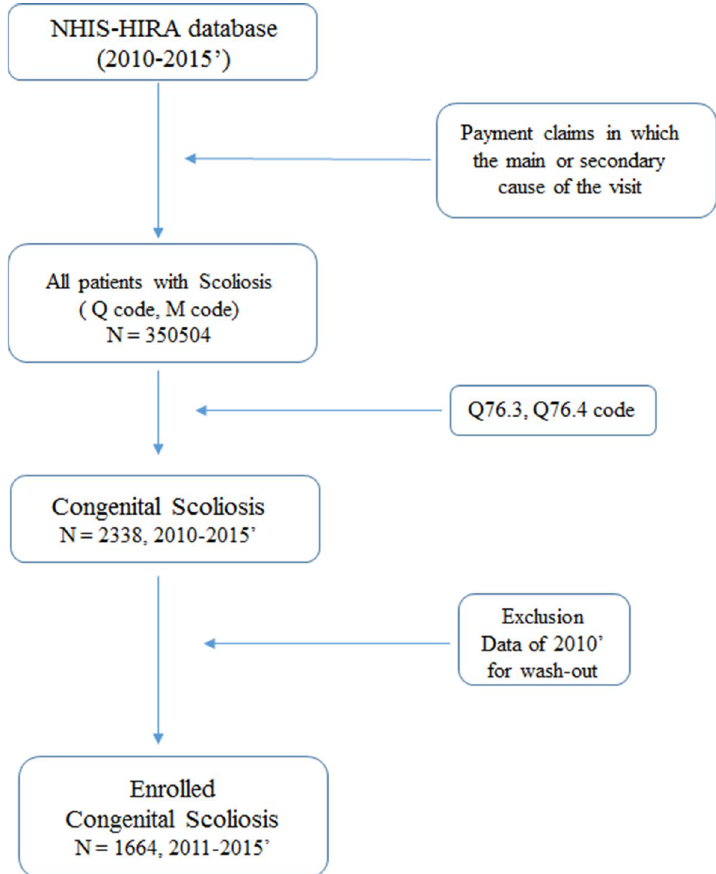
Figure 1. Diagram of the present nationwide scoliosis investigation of HIRA and NHI data. Cases of congenital scoliosis (defined as ICD-10th revision, Q76.4, Q76.3) were extracted from the NHIS-HIRA database